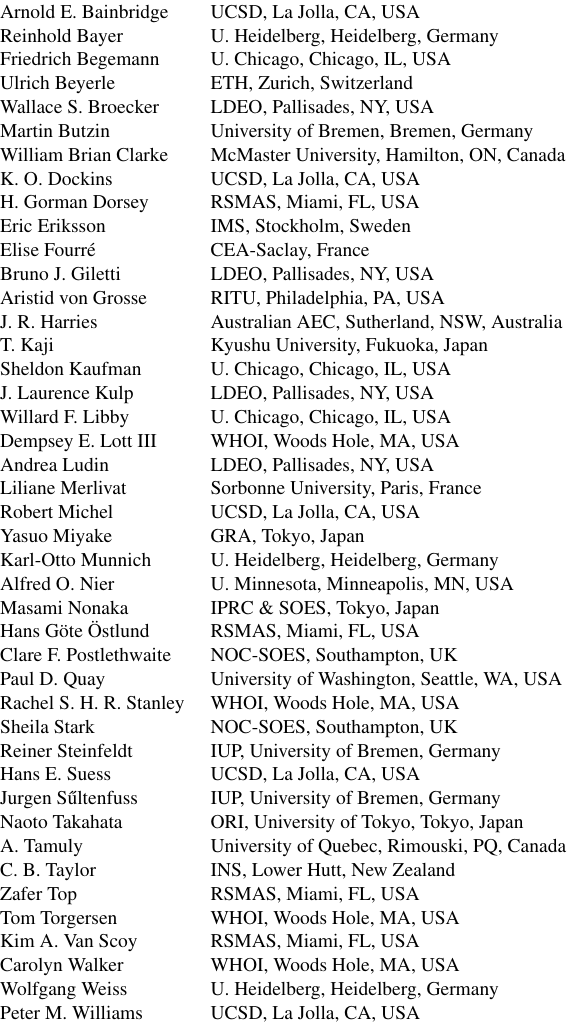
Table 3. Contributing analysts that are not authors on this